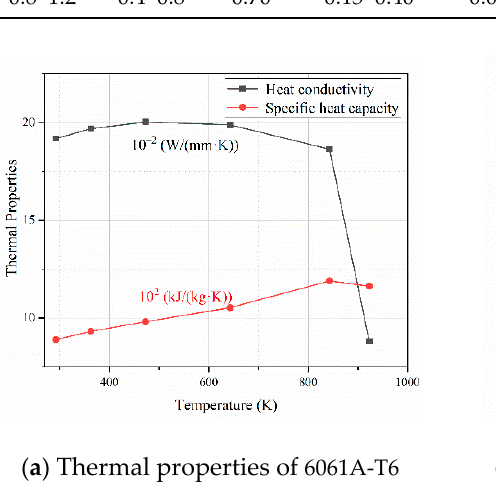
Figure 2. Temperature-dependent properties for 6061-T6. Table 1. Chemical composition of 6061A-T6 (wt.%).